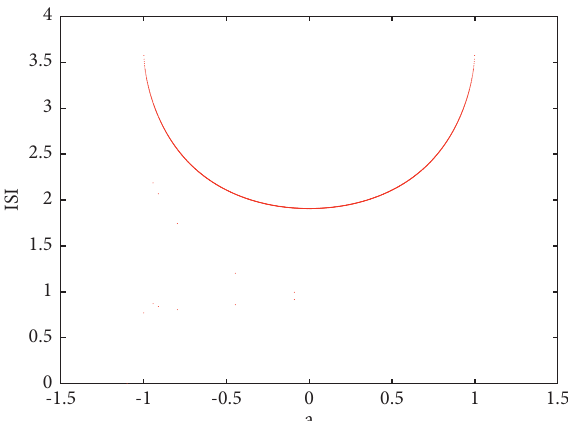
Figure 1: The bifurcation diagram of FHN neuron deterministic system with parameter a